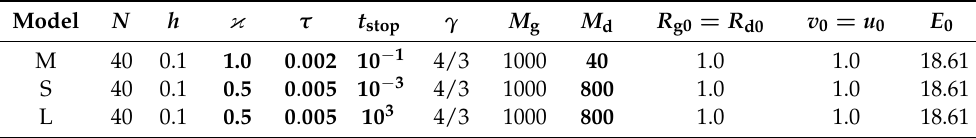
Table 1. Numerical and physical parameters of the models. N is the number of particles of one phase along the ball diameter. Parameters differentiating between the models are shown in bold, and identical parameters for all models are in normal